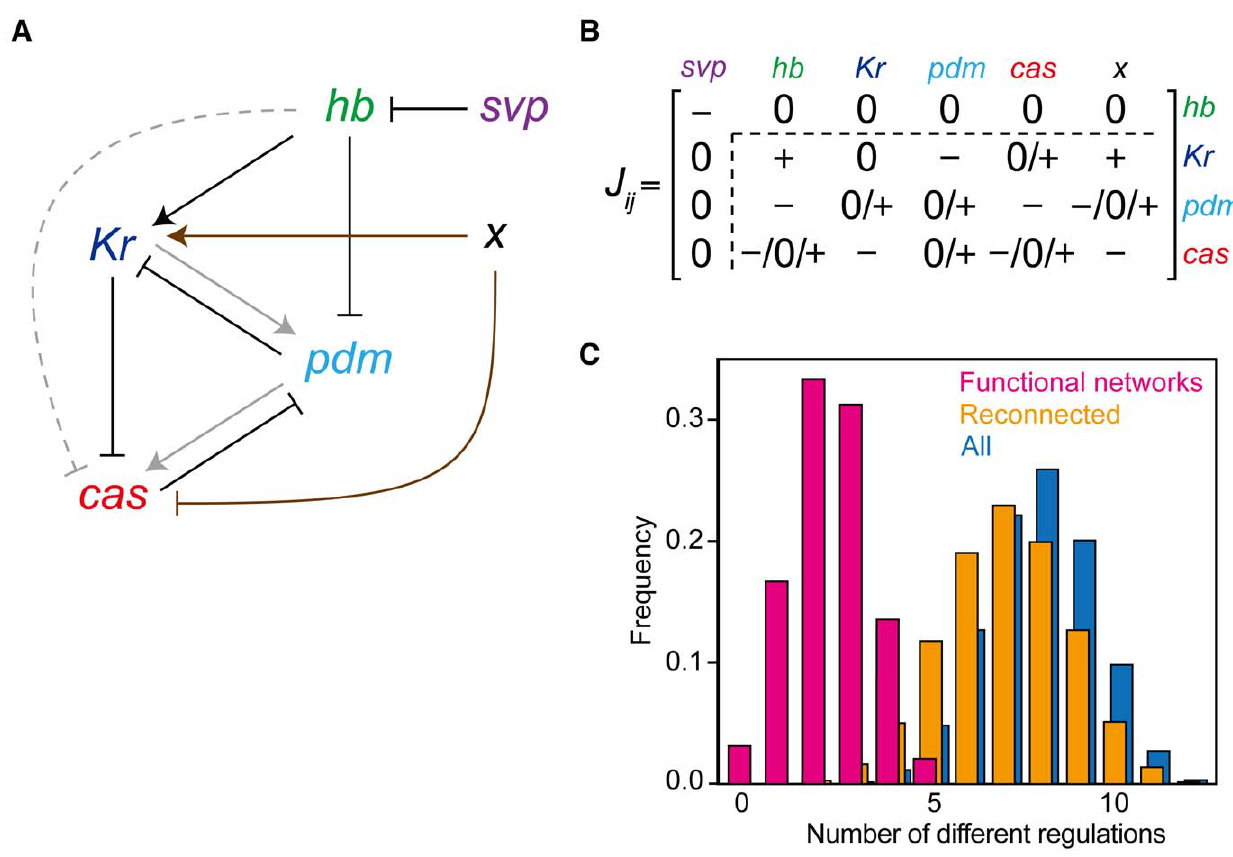
Figure 3. Architecture of the detected functional networks. ( A ) Architecture of the functional networks reproducing the gene expression profiles observed in the experiments. The black arrows are the regulations that appear in all the functional networks. The brown arrows are the regulations from the presumptive factor x that also appear in all the functional networks. The other regulations existing in the actual Drosophila network are shown by gray arrows. ( B ) Matrix representation of the functional networks. Elements of { J ij } are shown as either + for activation, 2 for repression, or 0 for the absence of regulation. ( C ) Frequency distributions of the distances of networks from the Drosophila network. The distributions are drawn from the functional networks ( N =384; magenta), all the possible networks ( N =14,348,907; blue), and the networks randomly reconnected from the functional ones ( N =38,400; yellow). From each of the functional networks, 100 reconnected networks were generated. The regulatory interactions from x and positive self-feedbacks are neglected in counting the number of different